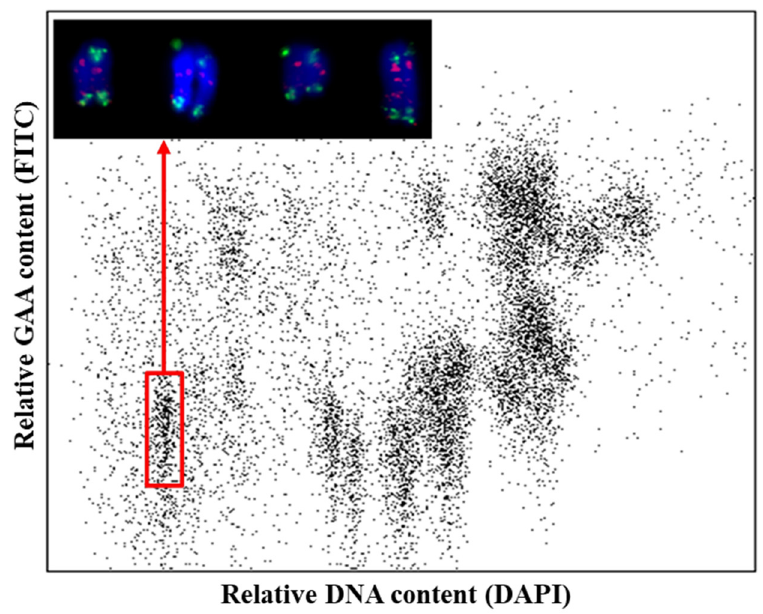
Figure 1. Flow sorting of H. villosa chromosome arm 6VS. Bivariate flow karyotype obtained after the analysis chromosomes isolated from bread wheat- Haynaldia villosa 6VS ditelosomic addition line. Prior to analysis, GAA microsatellite repeats on chromosomes were labeled by fluorescein isothiocyanate (FITC) and counterstained by 4 ′ ,6-diamidino-2-phenylindole (DAPI). The population representing 6VS telosome is marked by a red rectangle. The inset shows examples of flow-sorted 6VS telosomes after fluorescence in situ hybridization (FISH) with probes for pSc119.2 (yellow-green) and Afa family repeats (red). Table 1. The statistics of assembly of flow-sorted short arm of H. villosa 6V